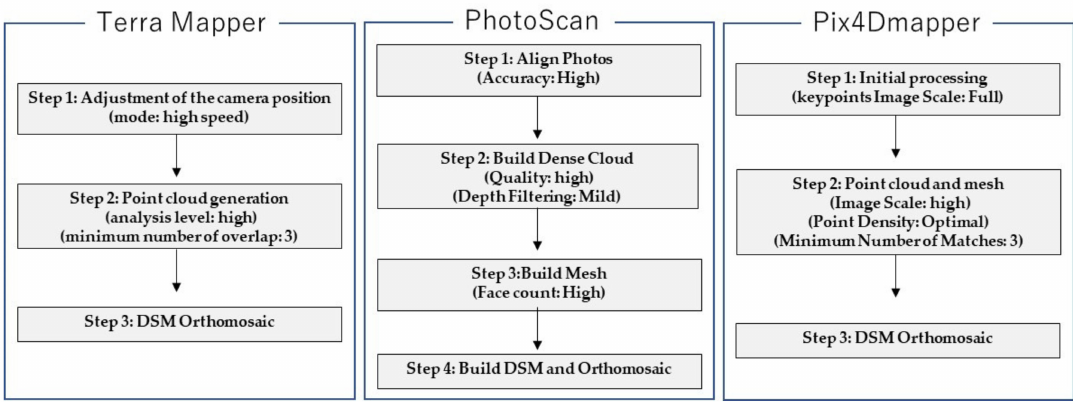
Figure 3. Image processing steps for each SfM software. Note: Terra Mapper is on the left, PhotoScan is in the middle, and Pix4Dmapper is on the